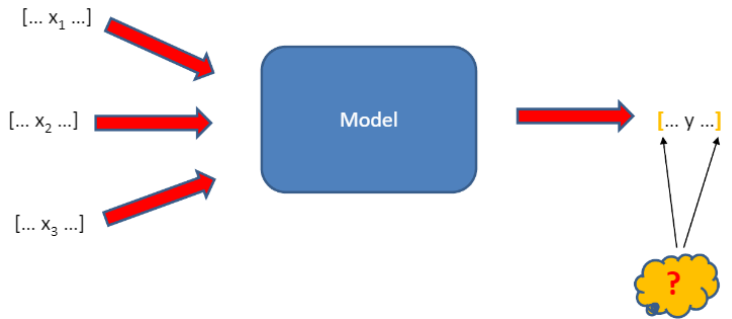
Figure 3. Model of sensitivity analysis.